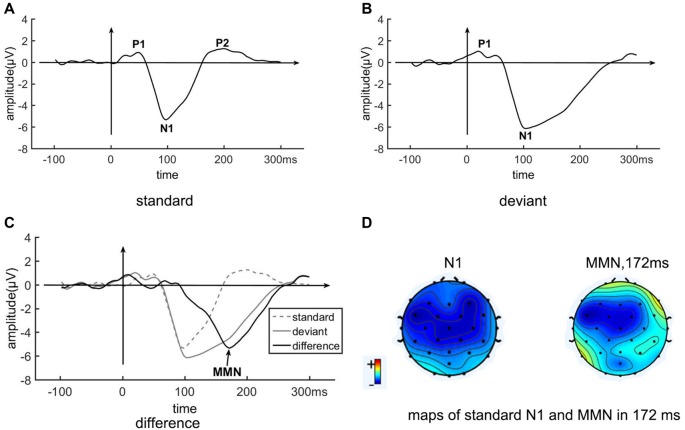
The event-related potential (ERP) of the standard stimulus, deviant stimulus, and MMN from the pooled electrode FC1/FC2/Fz/Cz. Panel (A) shown is the EPR of the standard condition. Panel (B) shown is the ERP of the deviant condition. Panel (C) shown is the EPR of the different wave (deviant—standard ERPs), as well as the EPR of the standard (dotted) and deviant (gray) conditions. (D) Maps of N1 of the standard condition and of the MMN at 172 ms, which is the peak time of the MMN.